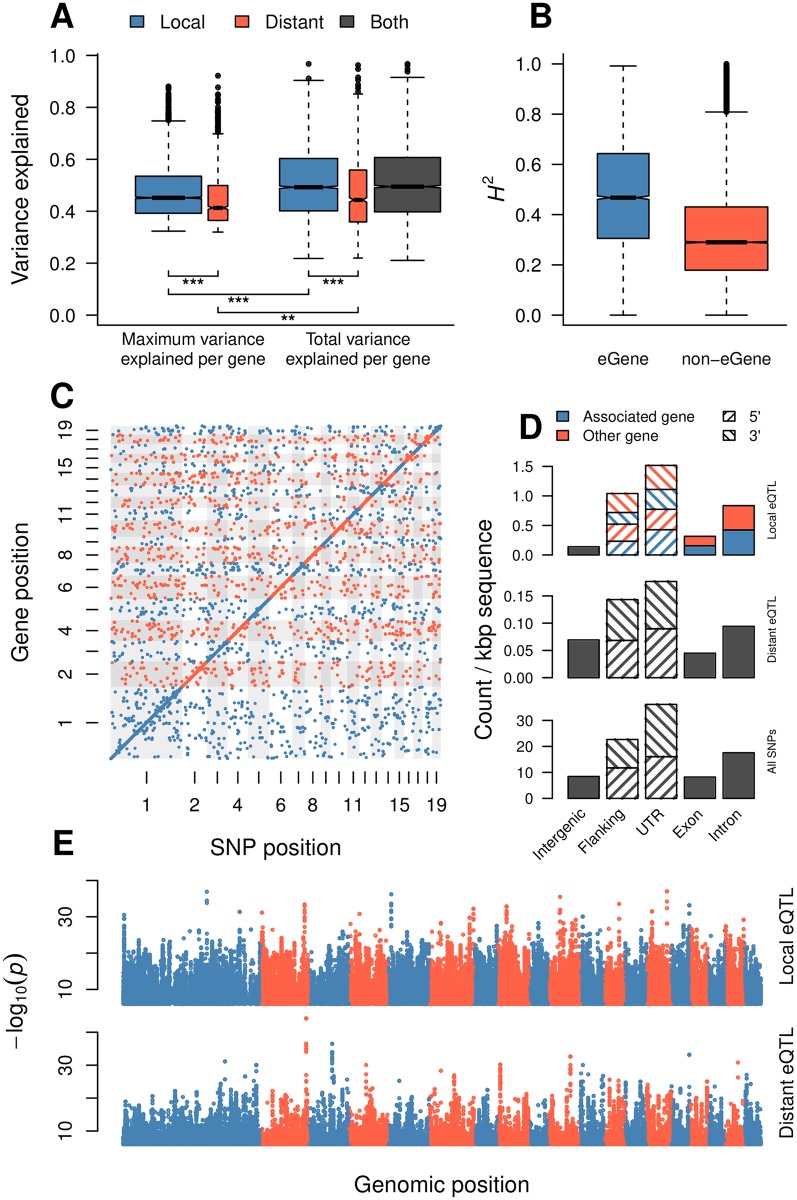
eQTL overview.(A) Expression variance explained (R2) for local and distant eQTLs. Box plots show the maximum variance explained by a single eQTL for each gene and the total variance explained by all eQTLs for each gene. The widths of the boxes are proportional to the number of genes represented. The pairwise significiance of a Mann-Whitney test is indicated by asterisks: ***p < 0.001, **p < 0.01. (B) Broad sense heritability distributions for eGenes and non-eGenes. (C) Scatter plot showing the positions of all significant eQTLs in this study. No evidence of eQTL hotspots can be observed. Numbers indicate chromosome. (D) Genomic context of local and distant eSNPs. Context categories are normalized for feature length. When an eSNP overlapped with features on both strands, both of them were counted. For both local and distant eQTLs the features are based on the gene that is closest to the eSNP, and furthermore, for local eQTLs, the features are divided into whether the eSNP is located in or near the same gene that it is associated to (“associated gene”) or not (“other gene”). Flanking regions represent 2 kbp upstream and downstream from the gene. (E) Manhattan plots for local eQTLs (upper) and distant eQTLs (lower). Each point represents an eQTL.